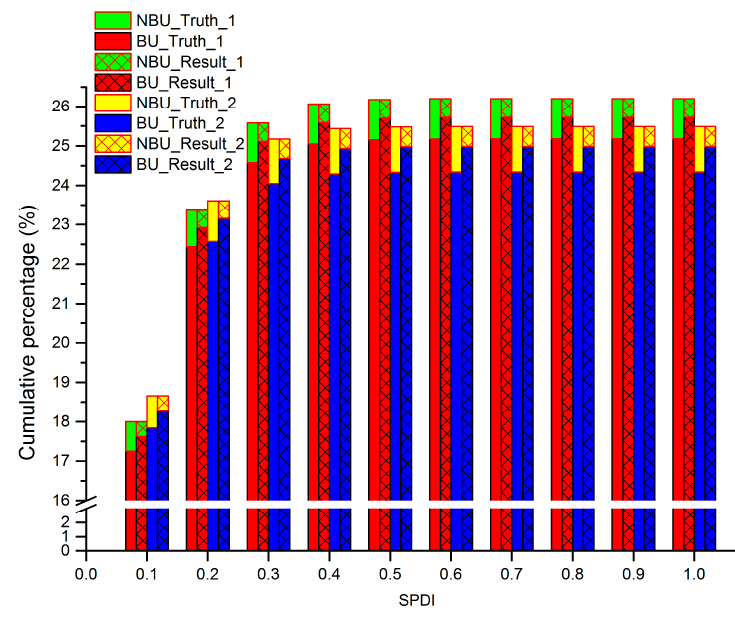
Figure 12. SPDI comparison for stereo pair 1.